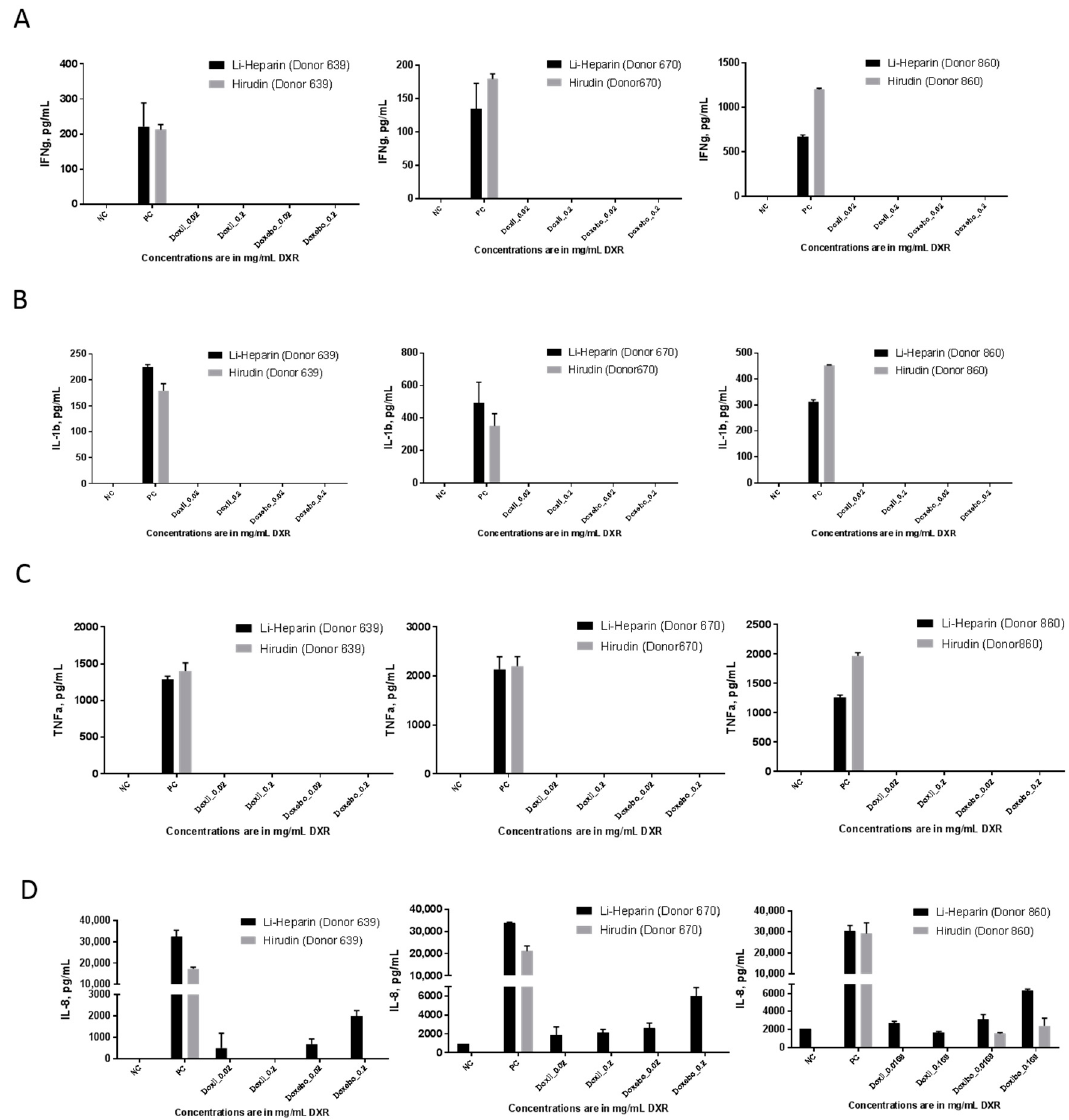
Figure 7. Cytokine response in PBMC. Doxebo and Doxil were tested at two clinically relevant concentrations in the PBMC cultures derived from the blood of three healthy donor volunteers. Donor number is shown in parentheses. PBS was used as the negative control (NC), 10 ng/mL E. coli K12 LPS and 10 µg/mL PHA-M were used as PC. Supernatants were analyzed by ELISA to estimate concentrations of IFN γ ( A ); IL1- β ( B ); TNF α ( C ); and IL-8 ( D ). Three independent samples were prepared for each concentration and analyzed in duplicate (%CV < 20). Shown is the mean response ( n = 3) ± SD. BLOQ = below the limit of quantification.